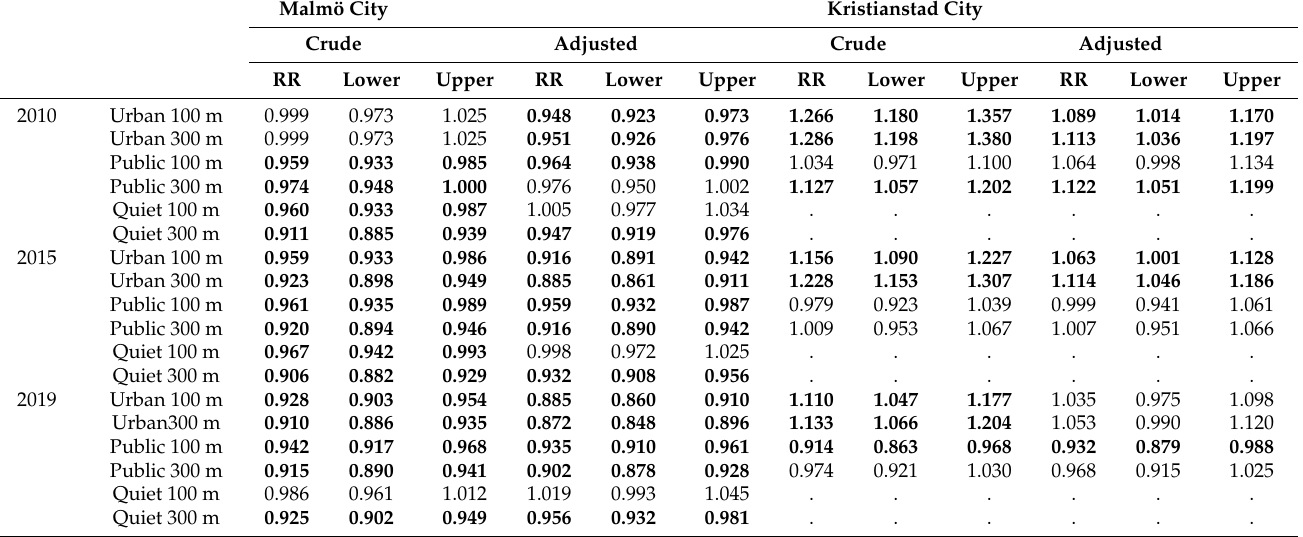
Table A1. Risk ratios for crude and multivariate associations between younger (65–74 years old) vs older (74+ years old) study participants in availability to total urban green space (Urban), publicly available urban green space (Public) and quiet publicly available urban green space (Quiet). RR for 100 m and 300 m buffer distances from the residence for the three different types of urban green spaces are presented.